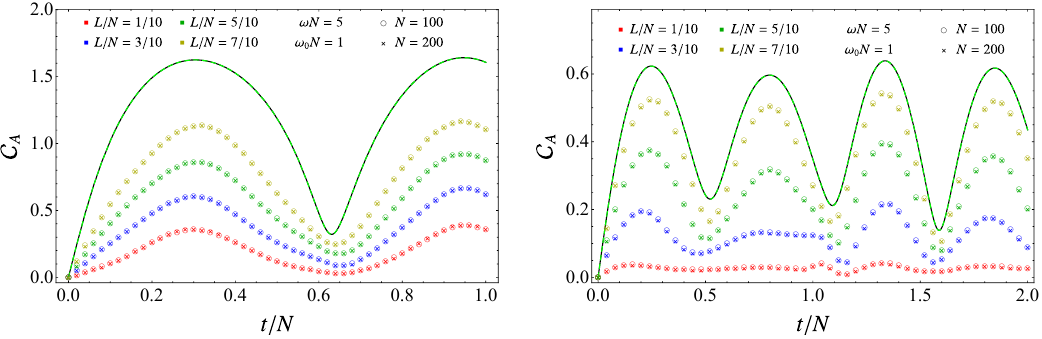
Figure 9 . Temporal evolution of C A in (4.6) after the global quench with a gapped evolution Hamiltonian for a block A made by L consecutive sites in harmonic chains with either PBC (left panels) or DBC (right panels) made by N sites (in the latter case A is adjacent to a boundary of the segment). When L = N the complexity (3.7) is shown for N = 100 (solid black lines) and N = 200 (dashed green